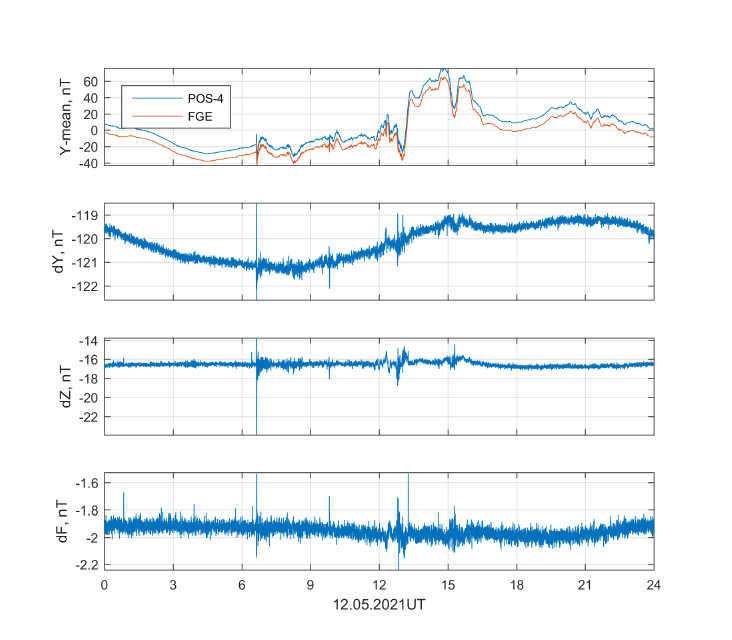
Figure 4. POS-4 and FGE-DTU data for 12.05.2021. The upper panel is values of component Y for POS-4 and FGE (the average values for the day are removed), the lower panels are the di ff erences of POS-FGE of the components Y, Z,